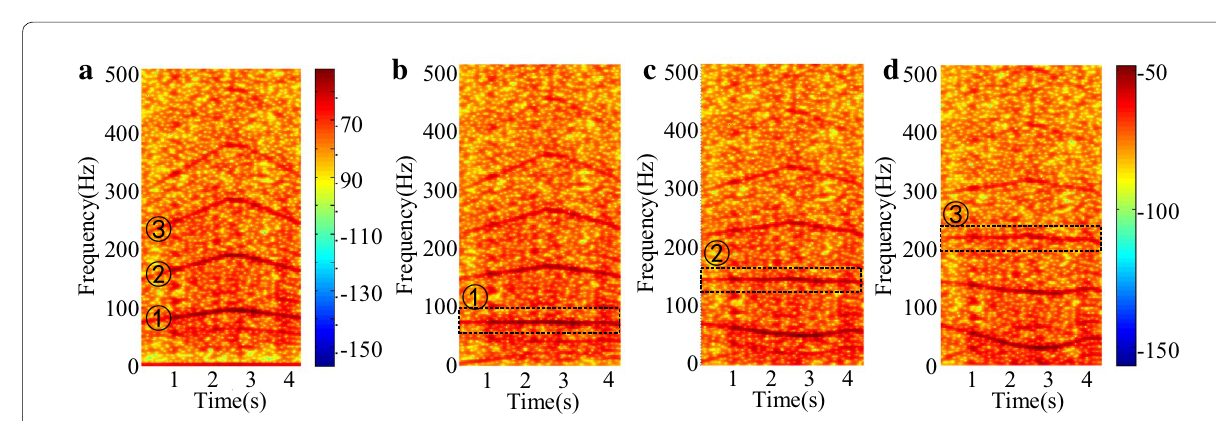
Figure 10 TFR comparison: a TFR of envelope signal; TFR of demodulated using different PFs: b s o ( t ), c 2 s o ( t ), d 3 s o ( t